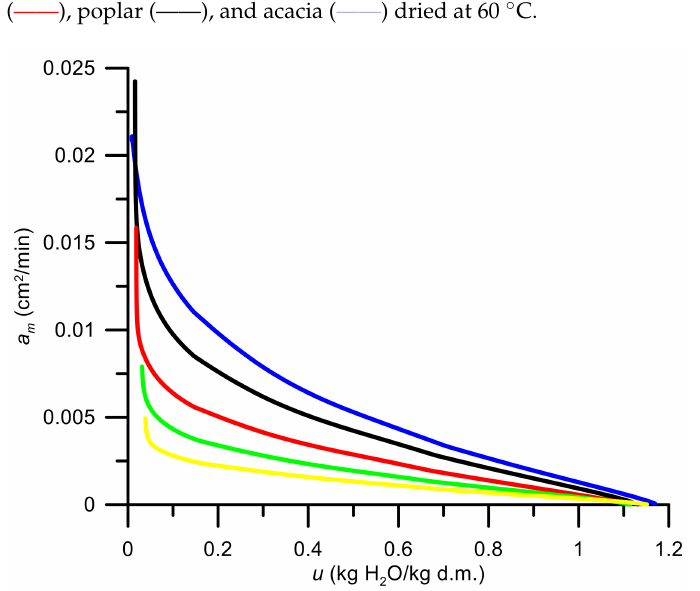
Figure 6. A graph of the diffusion coefficient versus water content in poplar particles drying at 40 ◦ C (——), 50 ◦ C (——), 60 ◦ C (——), 70 ◦ C (——), and 80 ◦ C